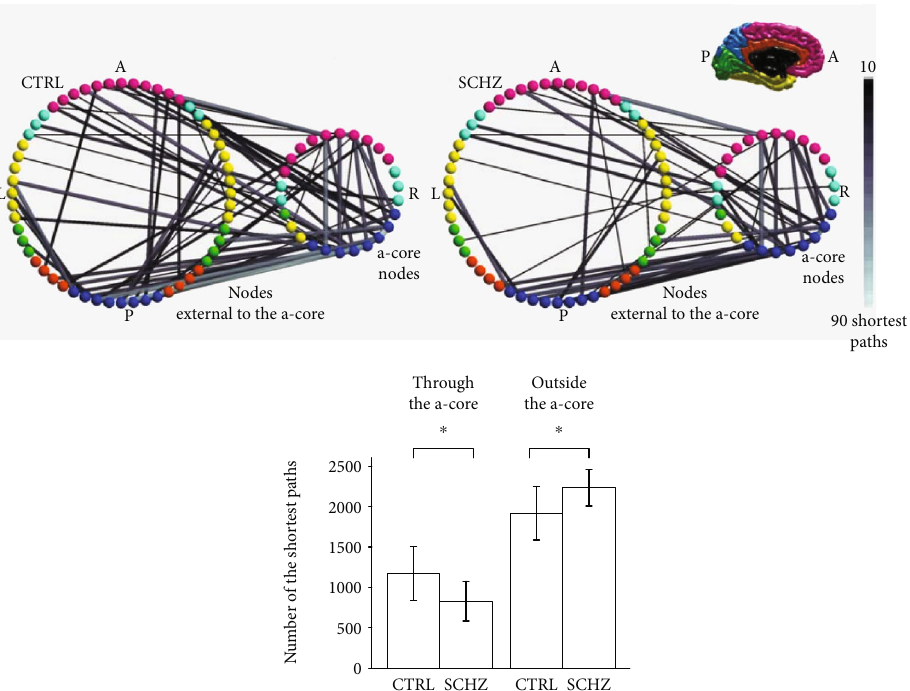
Figure 1: Reduced connections of brain areas in patients with schizophrenia